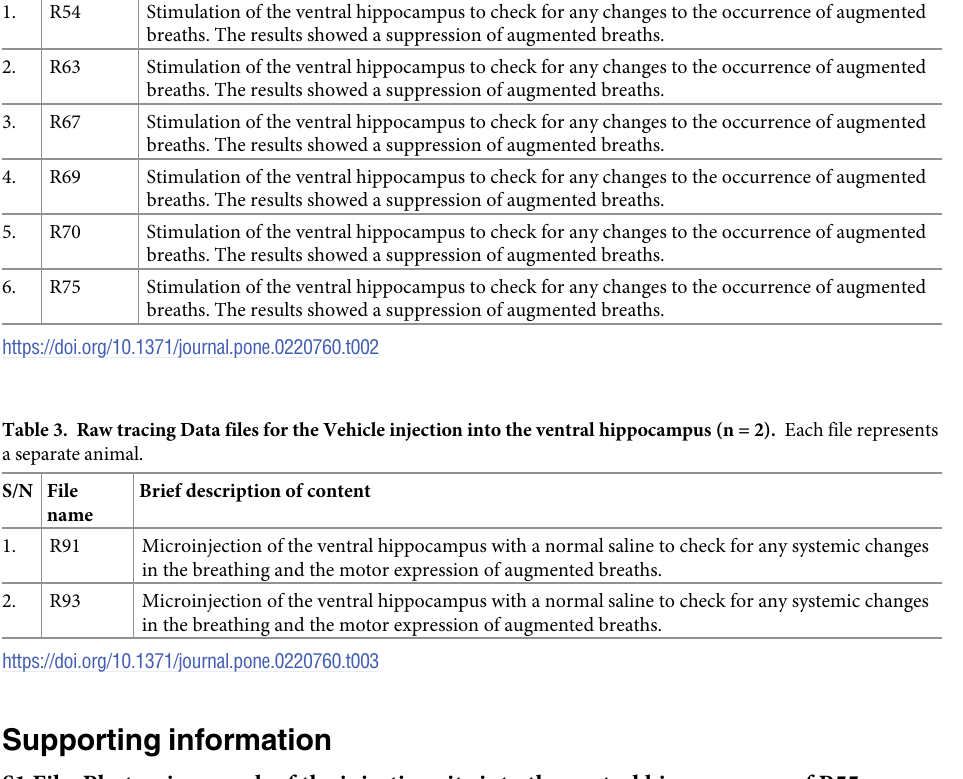
Table 2. Raw tracing Data files for the neurochemical microstimulation of the dorsal hippocampus (n = 6). Each file represents a separate animal. S/N File Name Brief description of the